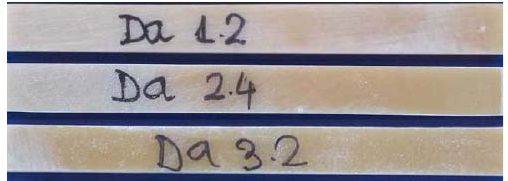
Figure 1. Samples of each